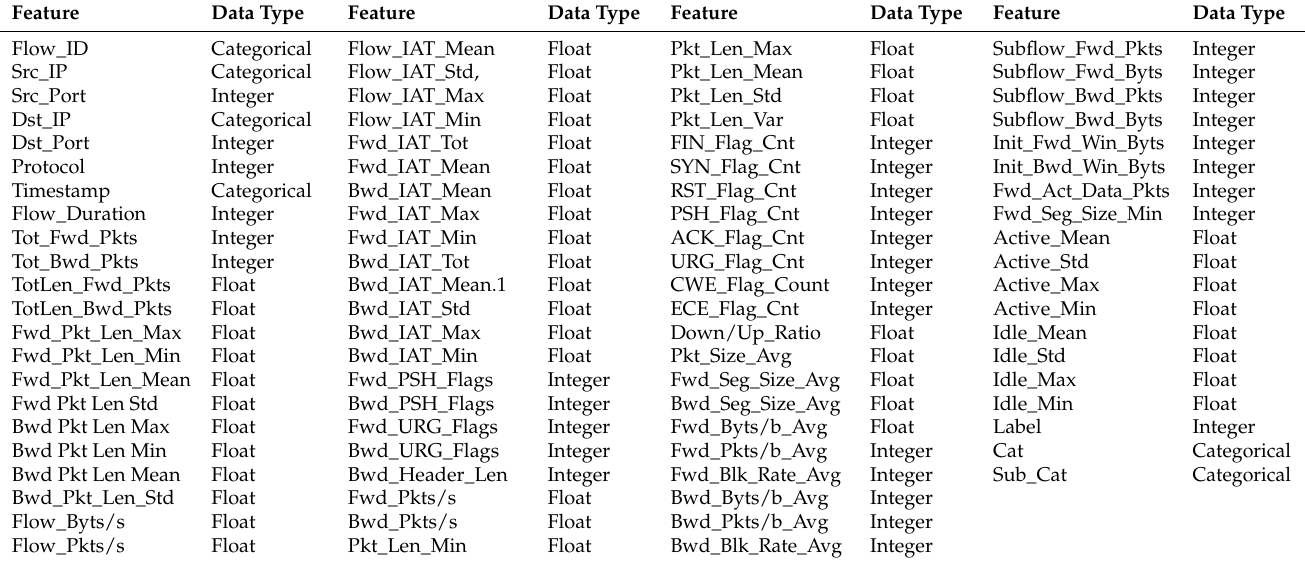
Table 2. IoT-Botnet 2020 Dataset Feature